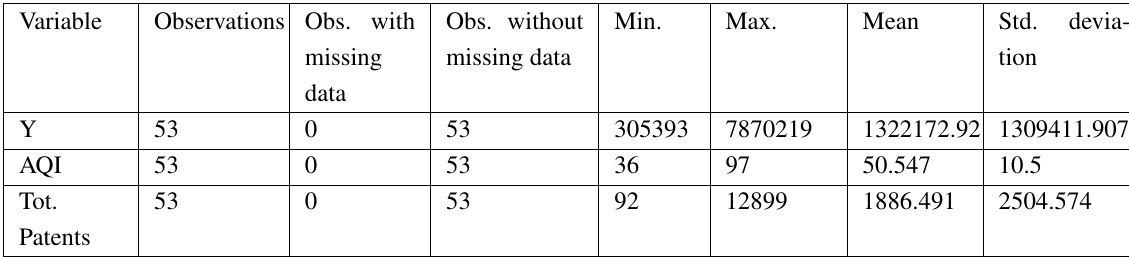
Table 3. Summary